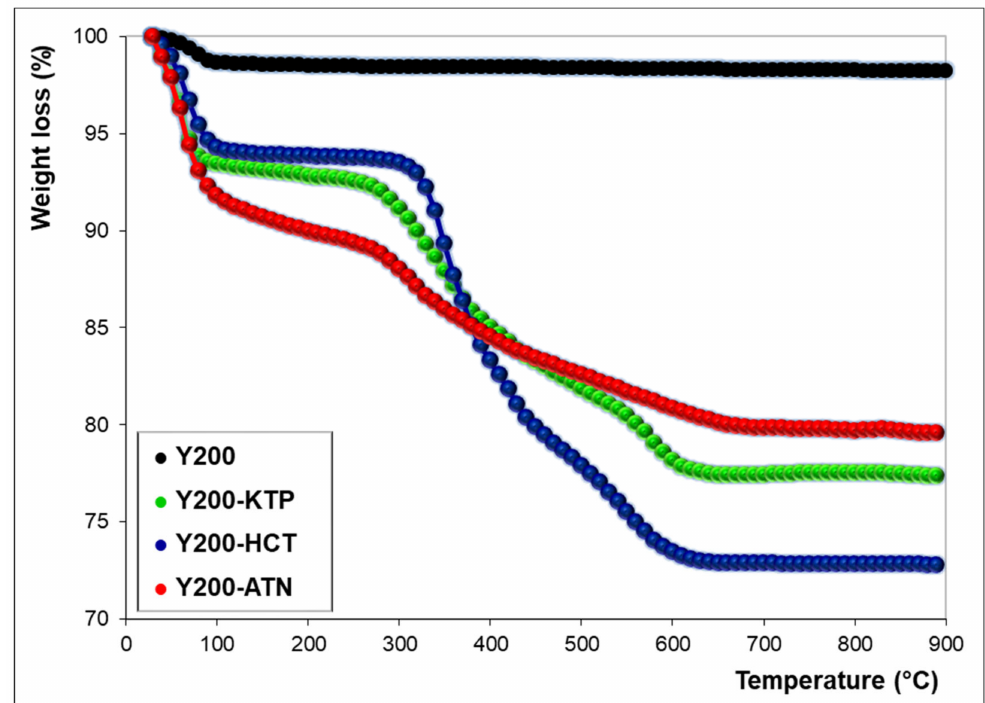
Figure 2. Thermogravimetric curves of Y200 before (black) and after drugs adsorption (KTP: Green, HCT: Blue, ATN: